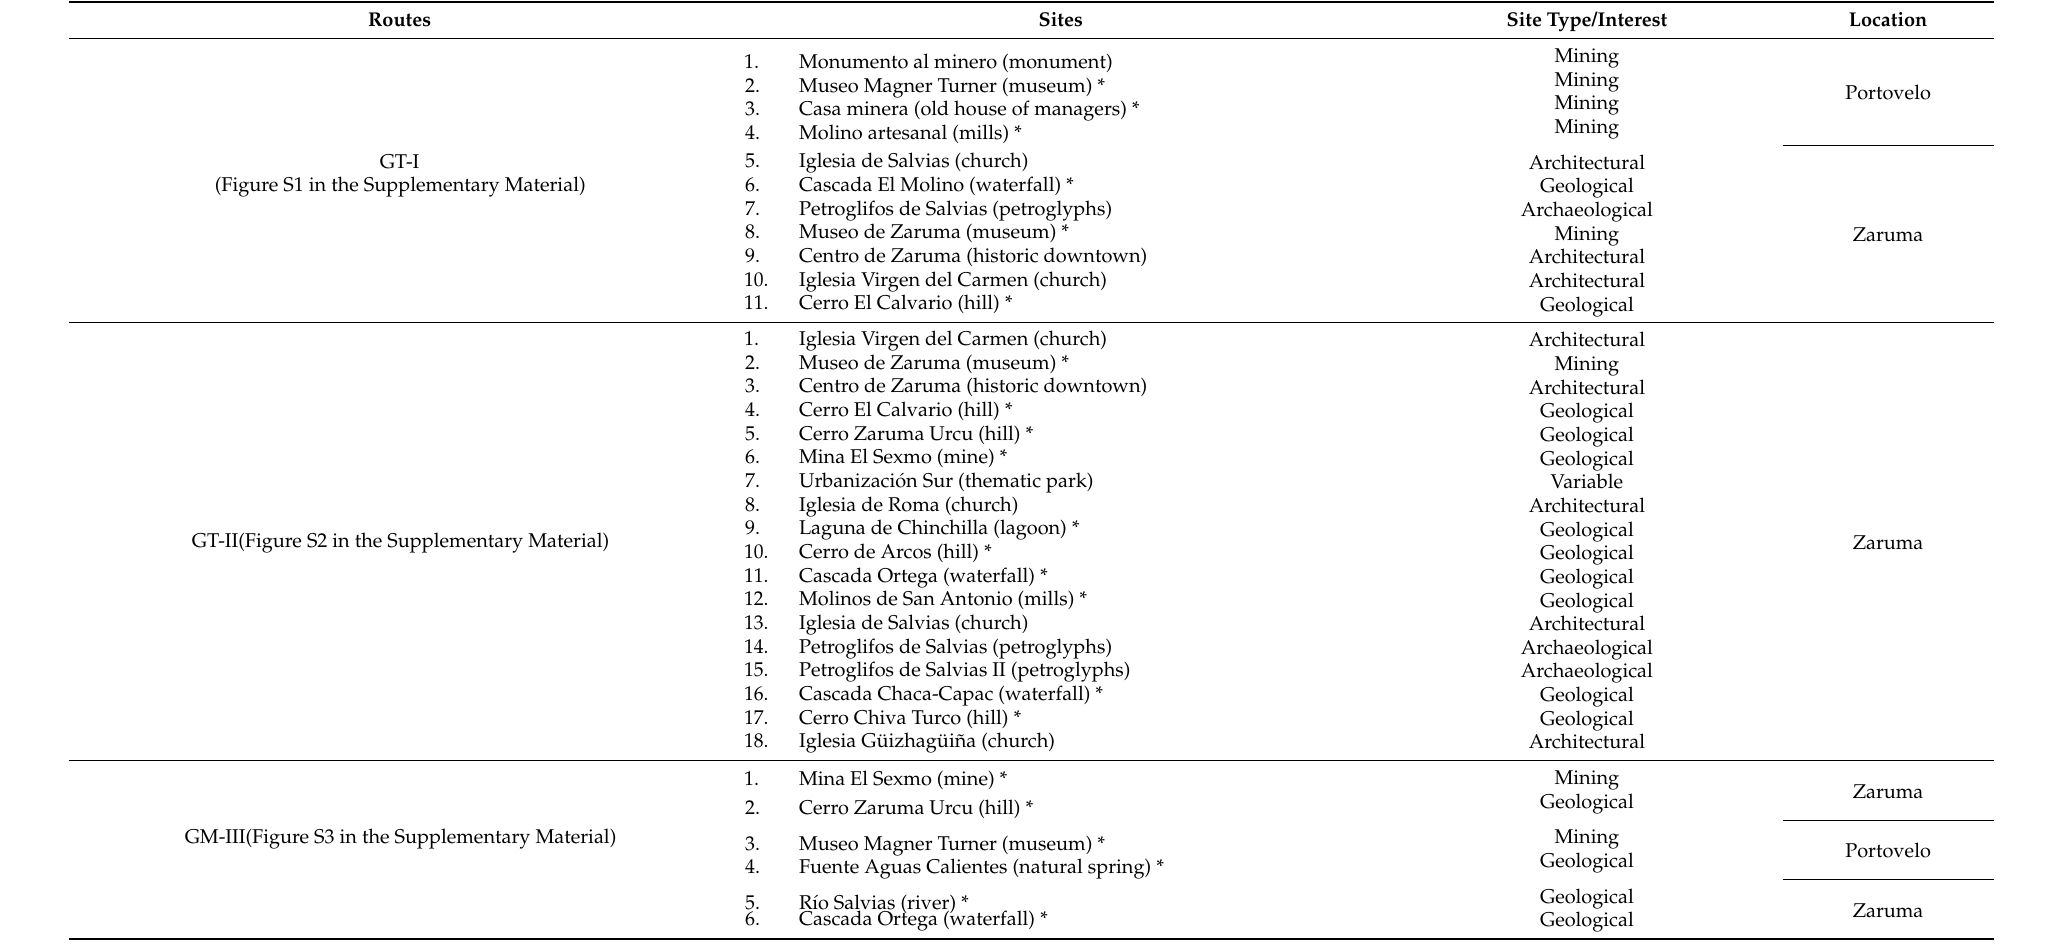
Table 2. Summary inventory of routes (two geotourists GT-I; GT-II and one geomining GM-III) proposed by other authors [34,60,61]. * Geosites/mining